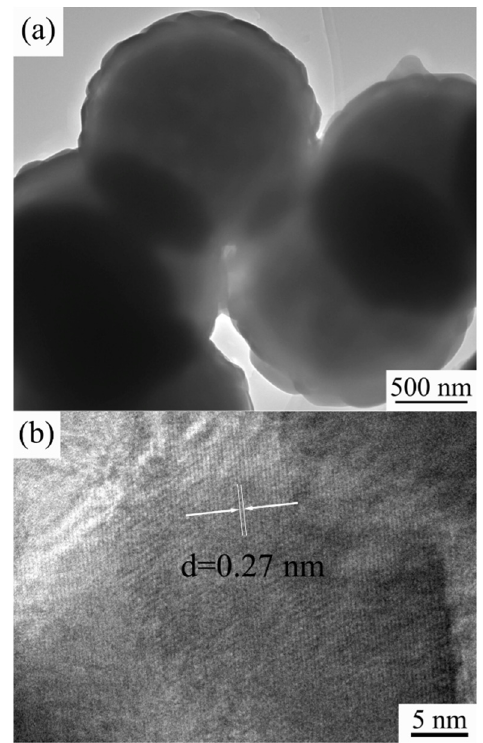
Figure 8. TEM ( a ) and HRTEM ( b ) images of the prepared composite pigments with a Co/Ni molar ratio of 0.5:0.5. ratio of